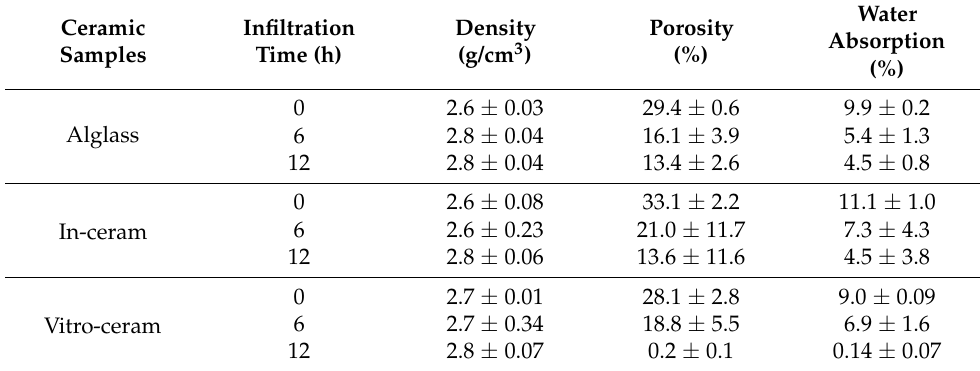
Table 3. Infiltration time, density, porosity and water absorption of sintered and infiltrated alumina preforms.